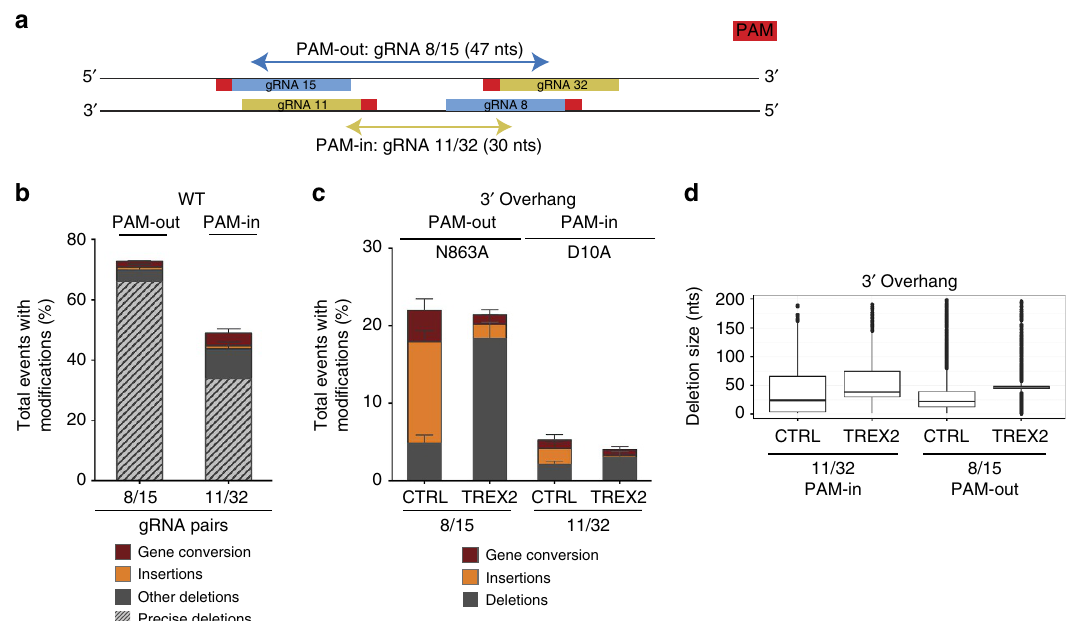
Figure 4 | Paired nickase-induced lesions in the PAM-in orientation do not result in efficient strand separation and locus modification. ( a ) Schematic showing the position of gRNAs 8, 15, 11 and 32 on the HBB locus, alongside the predicted overhang length and PAM orientation (red). ( b ) Overall modification frequency resolved for deletions, insertions and gene conversion scored by Sanger sequencing of the amplified HBB locus in U2OS cells expressing the WT Cas9 variant and gRNA pairs 8/15 (PAM-out) or 11/32 (PAM-in). Data are represented as mean ± s.e.m. Total number of sequences from four independent experiments is 324 for gRNA pair 8/15 and 280 for gRNA pair 11/32. ( c ) Overall modification frequency resolved for deletions, insertions and gene conversion scored by Sanger sequencing of the amplified HBB locus in U2OS cells expressing the N863A Cas9 variant and gRNA pair 8/15 (PAM-out) or the D10A Cas9 variant and gRNA pair 11/32 (PAM-in) in the presence (TREX2) or absence (CTRL) of the 3 0 –5 0 exonuclease TREX2. gRNA expression was driven from PCR products containing the U6 promoter, gRNA sequence and TRACR (Methods). Data are represented as mean ± s.e.m. The total number of sequences from three independent experiments is 203 for gRNA pair 8/15 CTRL, 572 for gRNA pair 11/32 CTRL, 224 for gRNA pair 8/15 TREX2 and 270 for gRNA pair 11/32 TREX2. ( d ) Box–whisker plot depicting the deletion size for either PAM-in gRNA pair 11/32 or PAM-out gRNA pair 8/15. Deletions were determined from sequences read by Illumina MiSeq. The line within the box depicts the median, with the box extending from the 25th to the 75th percentiles. The whiskers depict the minimum and maximum values within 1.5 inter-quartile range (IQR) of the median. Points with distance to median 4 1.5 IQR are shown